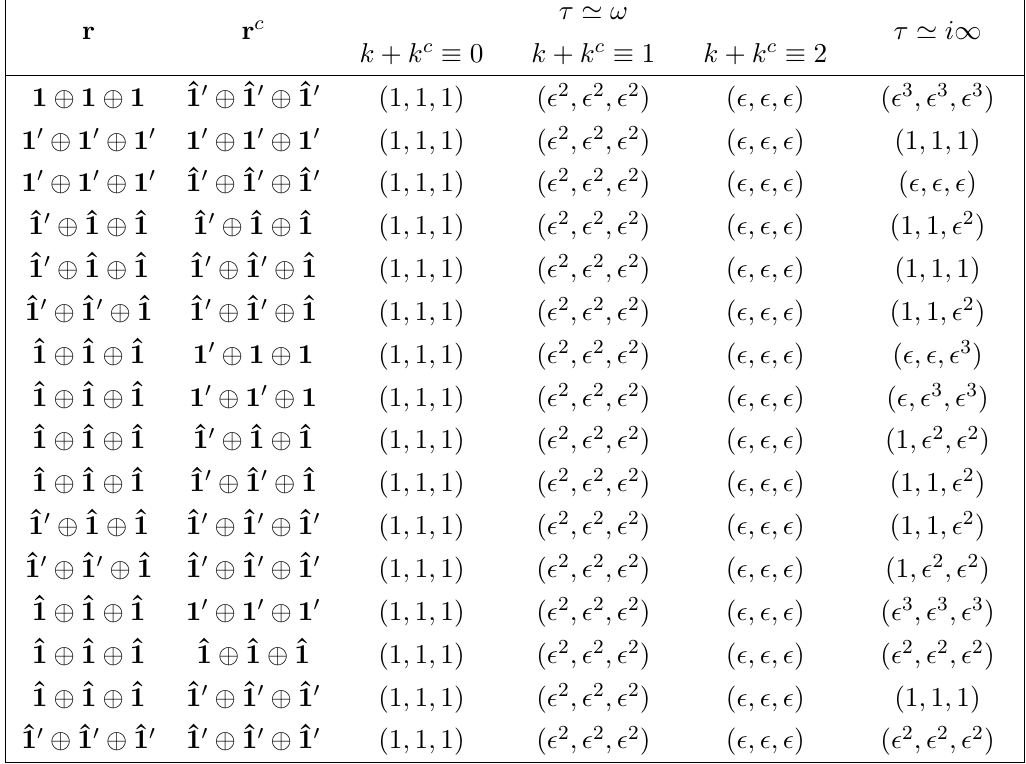
Table 12. Leading-order mass spectra patterns of bilinears ψ c ψ in the vicinity of the symmetric points ω and i ∞ , for 3d multiplets ψ ∼ ( r , k ) and ψ c ∼ ( r c , k c ) of the finite modular group Γ 0 = SL(2 , Z ) . Spectra are insensitive to transposition, i.e. to the exchange ψ ↔ ψ c . ’ S 0 4 4 4 Congruence relations for k + k c are modulo 3.